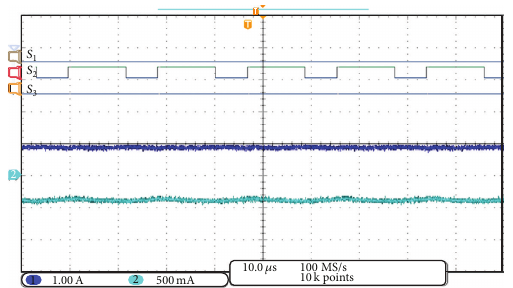
Figure 14: Operation when the energy is obtained from the battery , and 𝐼 𝐿 . The set from top to bottom: 𝑆 1 , 𝑆 2 , 𝑆 3 , 𝐼 𝐿 1 2 of both inductors is the same.